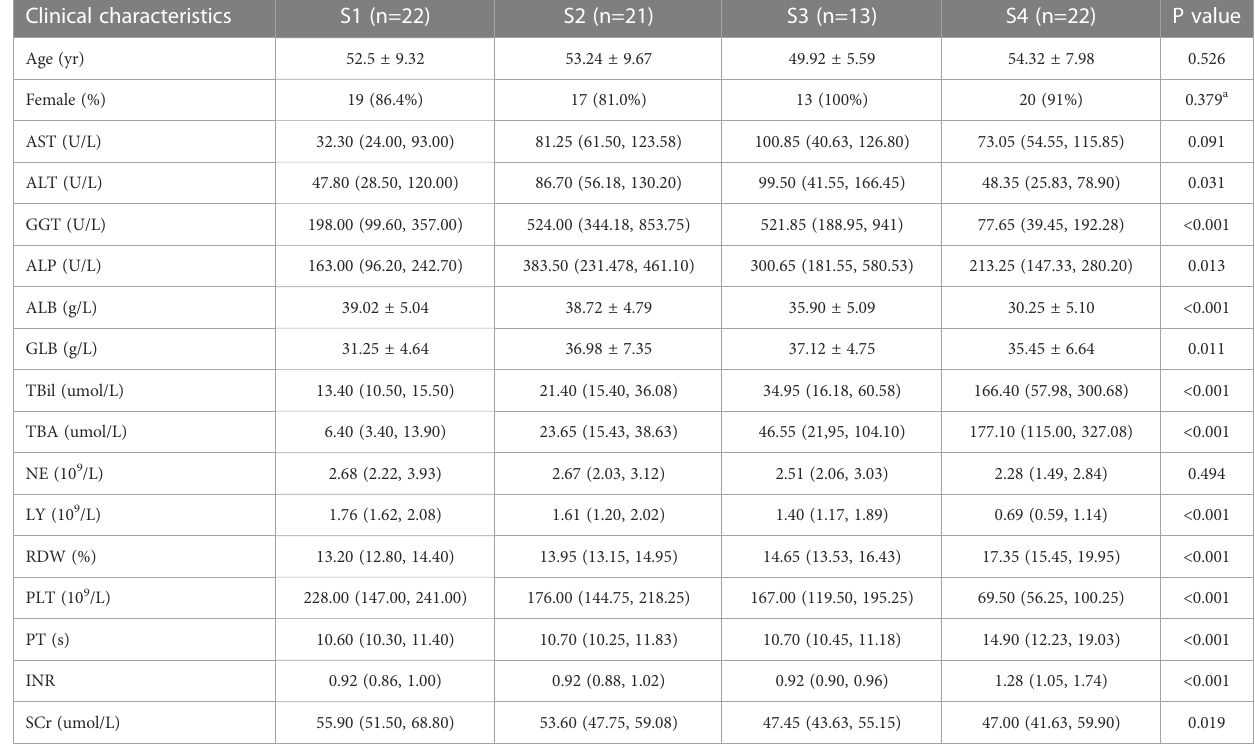
TABLE 2 Clinical characteristics of patients with different histological stages in the model group. Clinical